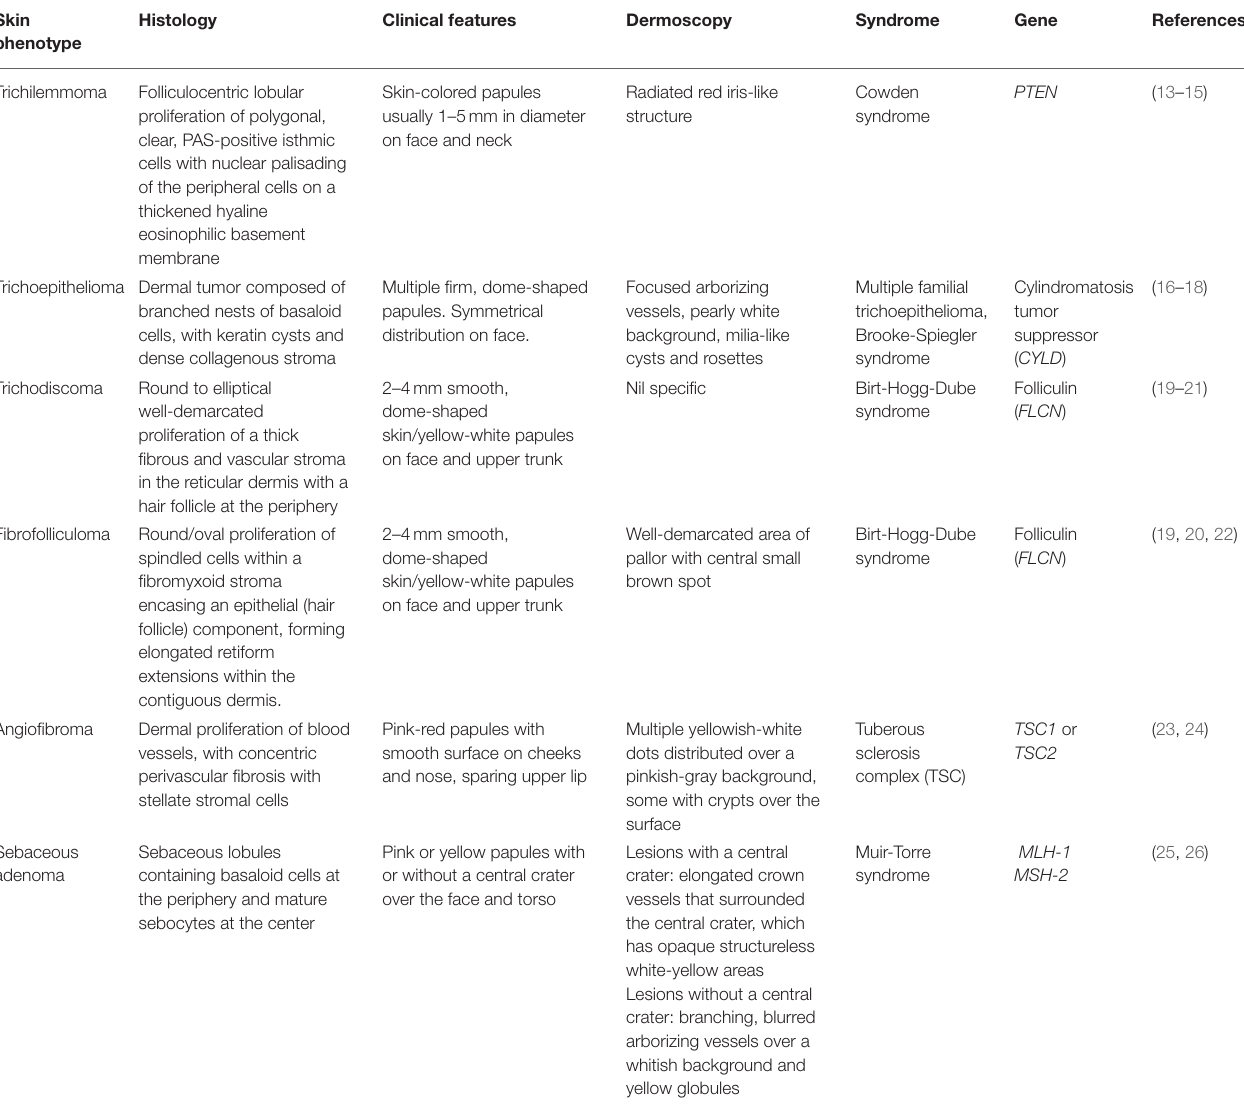
TABLE 1 | Differential diagnoses for genetic causes of multiple facial